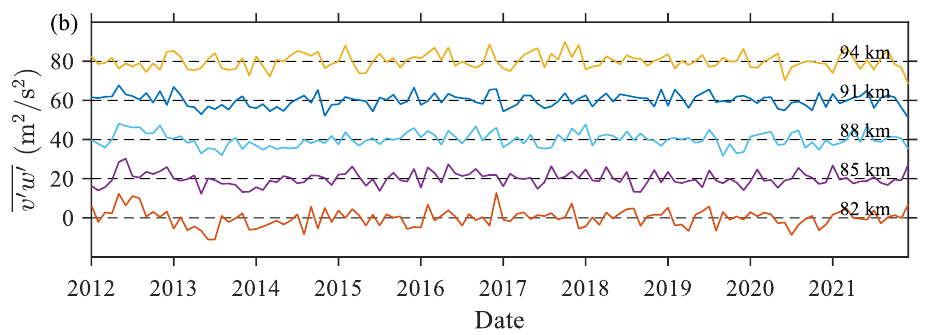
Figure 10. Time series of the detrended and deseasonalized ( a ) zonal and ( b ) meridional momentum fluxes at 82, 85, 87, 88, and 94 km, stacking with an interval of 20 m 2 /s 2 . The dashed lines are for zeros for each height.